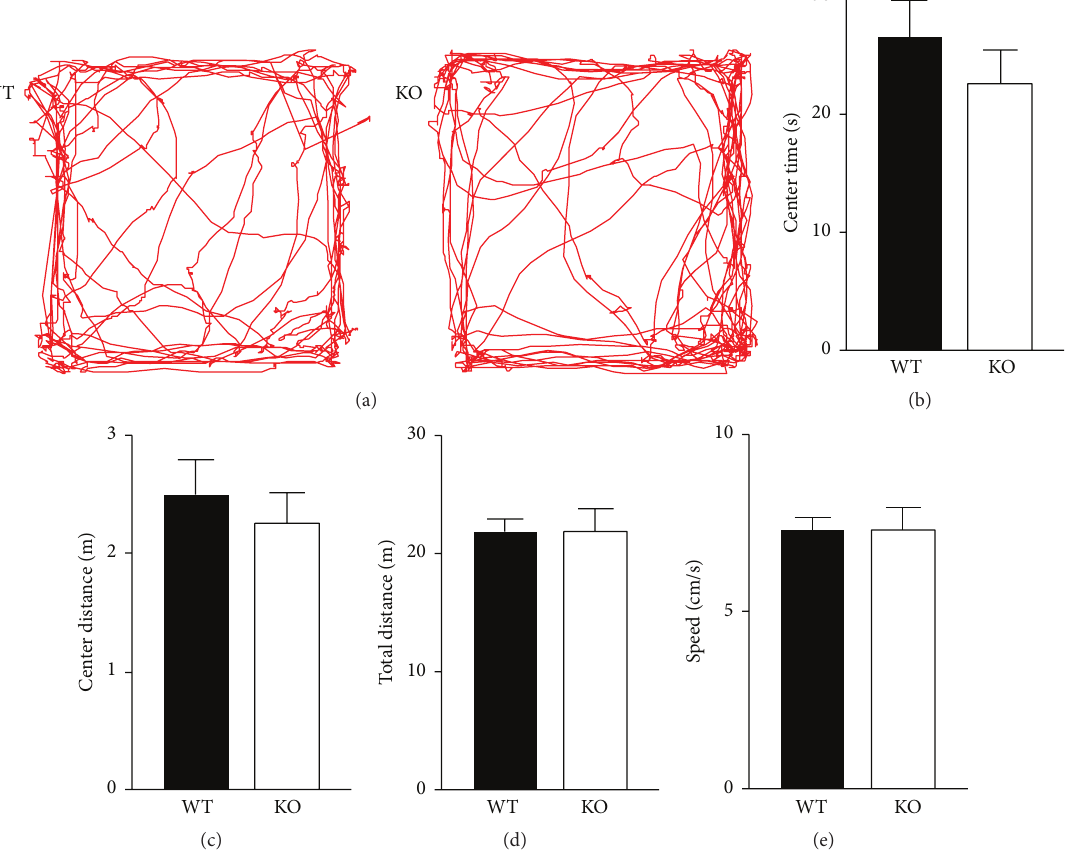
Figure 3: The levels of motor activity and anxiety assessed in an open field arena are normal in CB2R KO mice. (a) Representative tracking of mouse movement for 5 min in an open field arena (40 × 40 cm 2 ). (b–e) During the 5 min exploration period, KO and WT mice showed no significant difference from each other in the time spent in the center area (20 × 20 cm 2 ) of the arena (b), the travel distance in the center area (c), the total travel distance in the arena (d), or the mean speed of movement (e). Error bars represent SEM.